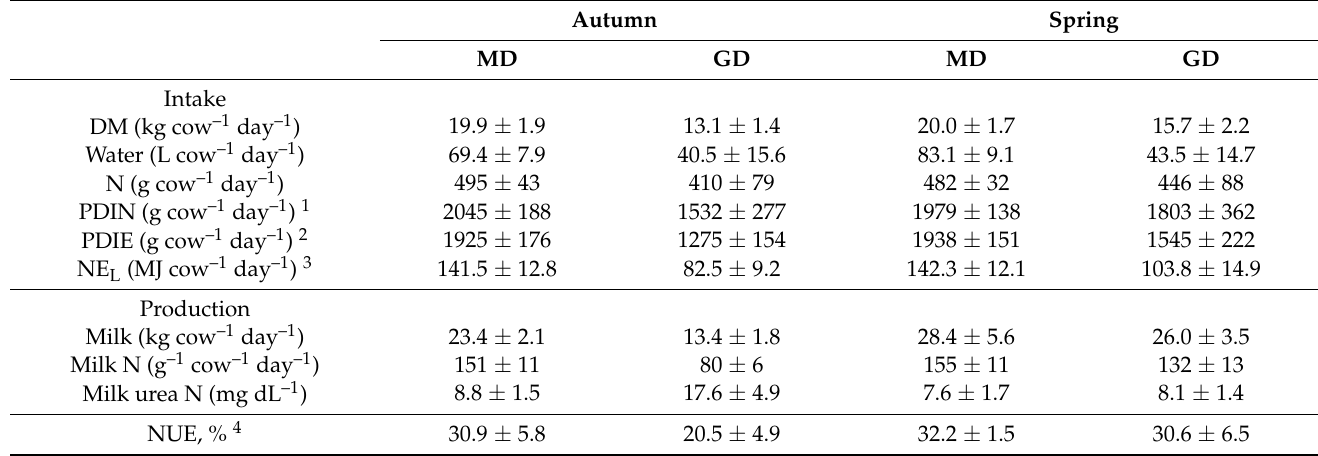
Table 2. Intake, production, and nitrogen (N)-use efficiency (mean ± SD) of dairy cows fed with a maize-silage-based diet (MD) or a grass-based diet (GD) and housed on a straw-based deep-litter system. Autumn Spring MD GD MD